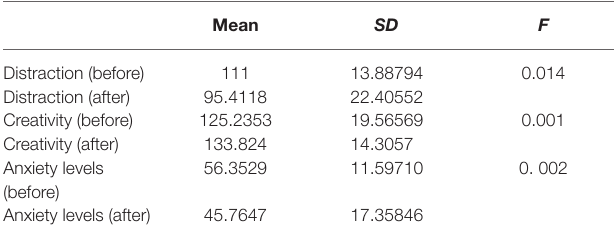
TABLE 1 | Paired T -test results of students’ creativity, distraction, and anxiety levels before and after AI and VR course training. Mean SD